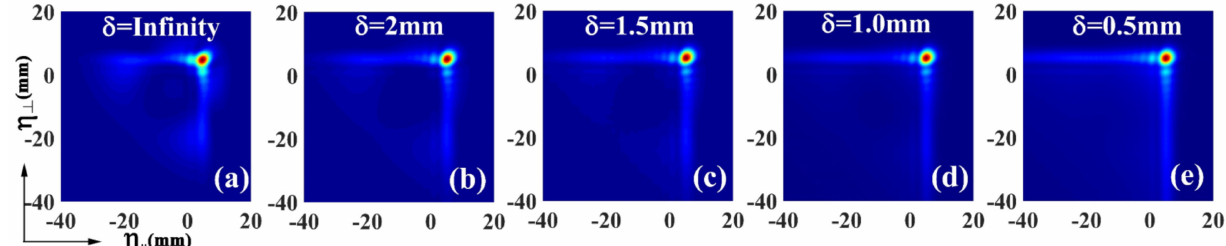
Figure 3. Density plots of the intensity distributions of ( a ) a conventional fully coherent Airy beam and ( b – e ) PCAB with different source coherence widths. The beam is obstructed by an opaque ob-stacle in the source plane, and the receiver plane is at Z = 160 m.